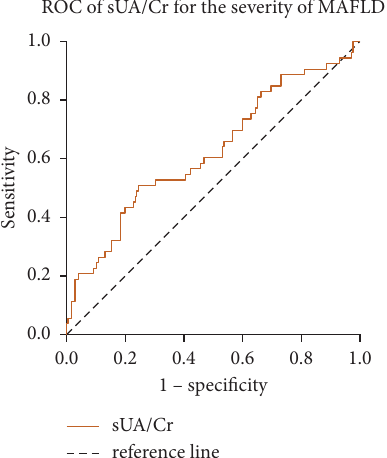
Figure 2: Receiver operating characteristics of serum uric acid to serum creatinine ratio for the severity of metabolic dysfunction- associated fatty liver disease. ROC, receiver operating character- istics; sUA/Cr, serum uric acid to serum creatinine ratio; MAFLD, metabolic dysfunction-associated fatty liver